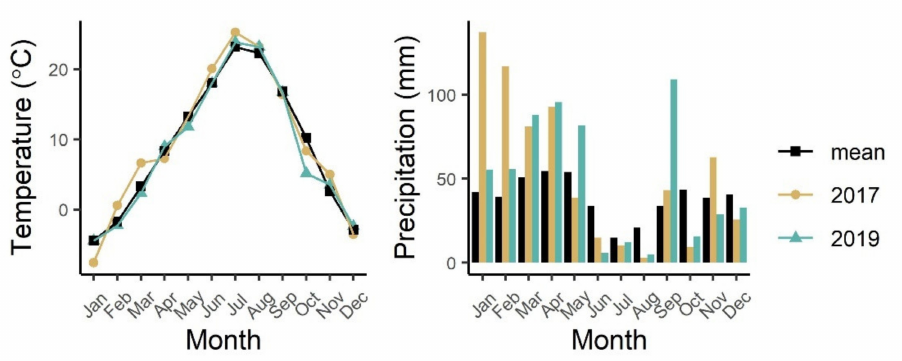
Figure 1. Monthly temperature and precipitation in 2017 and 2019, the years during which winter wheat was grown in plots. Historical mean monthly values of records from 1928–2019 are also shown.